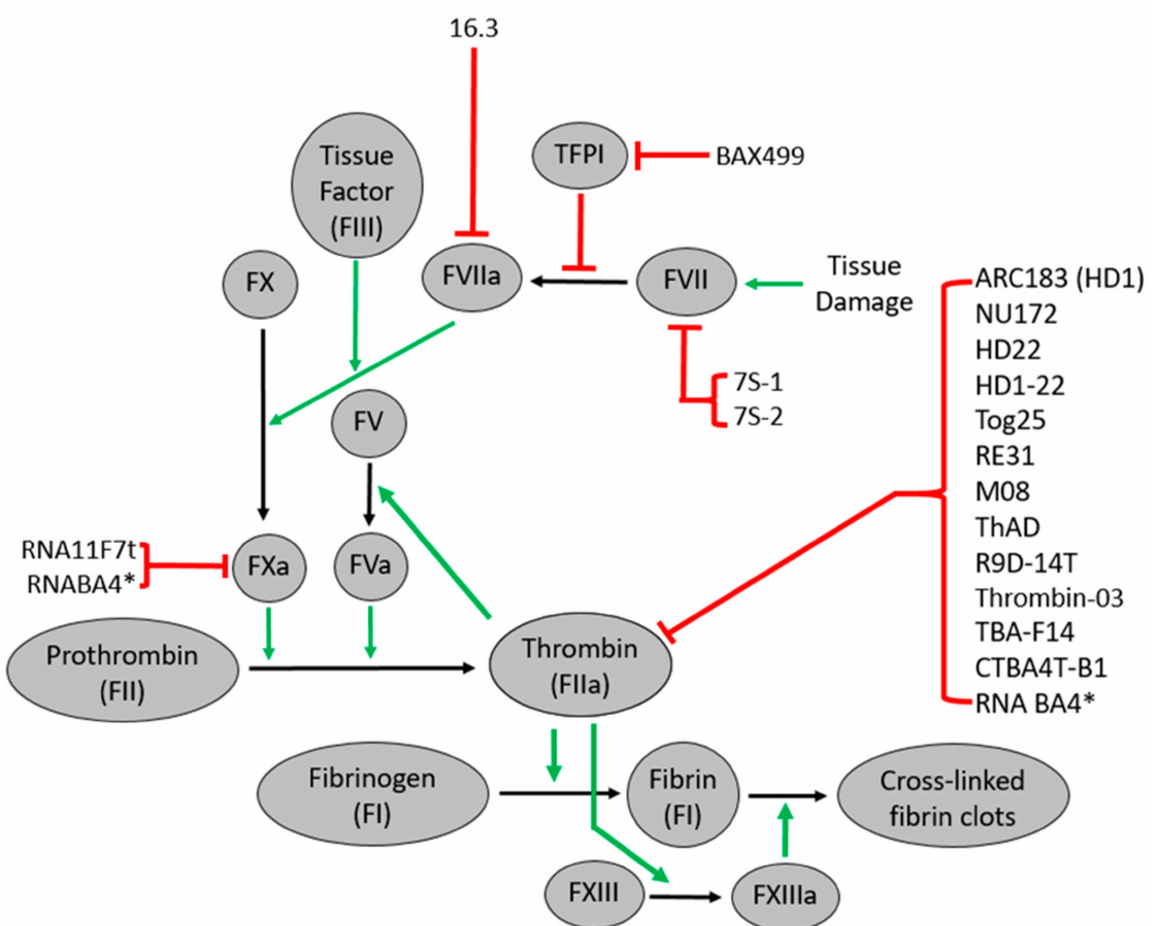
Figure 2. Extrinsic and common pathway aptamers. ARC183 (HD1), NU172, HD22, HD1-22, Tog25, RE31, M08, ThAD, R9D-14T, TBA-F14, and CTBA4T-B1 are aptamers that target thrombin. RNA 11F7t decreases clot formation by inhibiting prothrombinase assembly. * RNA BA 4 is a bivalent made by linking RNA 11F7t and R9D-14T and works as an anticoagulant by blocking FXa and thrombin. BAX499 blocks TFPI inhibition of FXa and the TF/FVIIa complex. Aptamer 16.3 promotes anticoagulation by inhibiting FVIIa, while 7S-1 and 7S-2 serve as anticoagulants by inhibiting FVII (Appendix